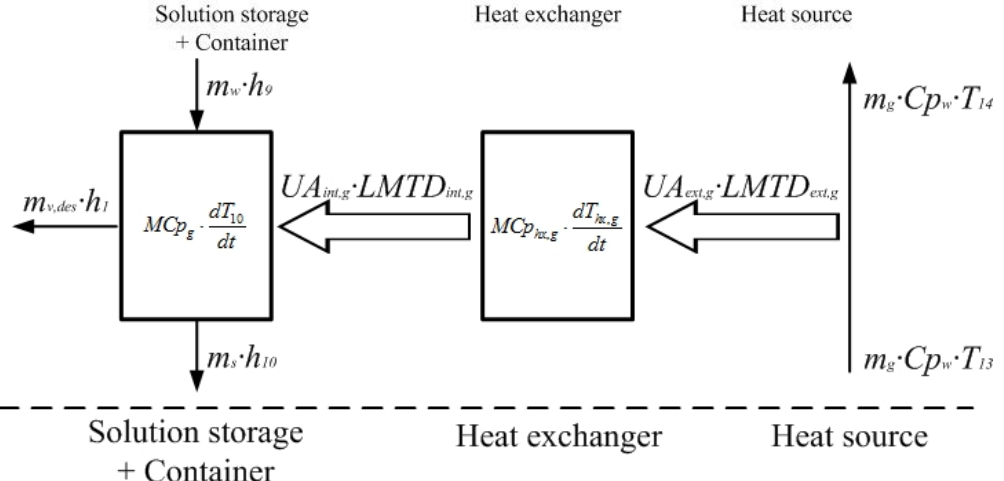
Figure 2. The energy flow diagram in the generator; LMTD ext , g : external logarithmic mean temperature difference in the generator.